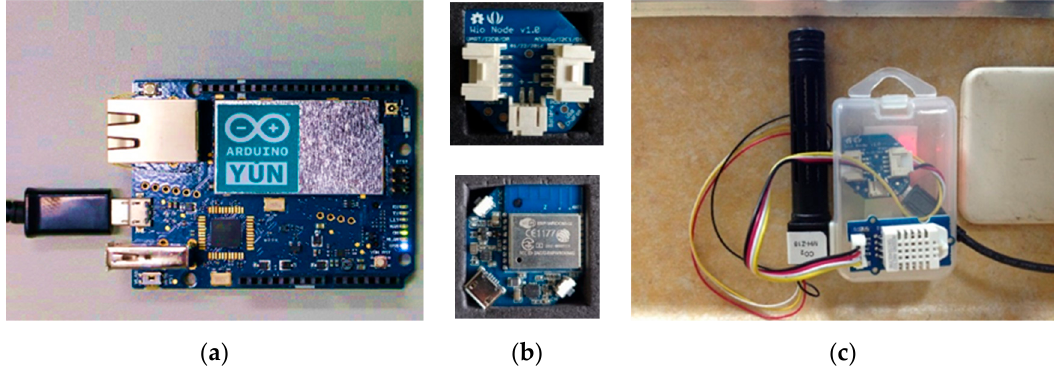
Figure 3. Actual installation status of the sensor. ( a ) Arduino Yun; ( b ) Wio Node; ( c ) Sensor Assembly.